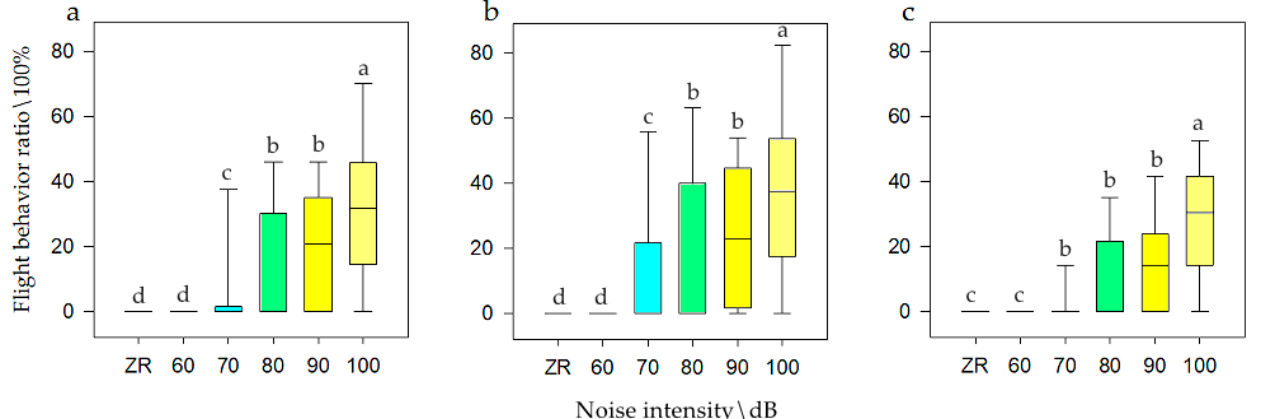
Figure 5. Flight behavior of bean geese (( a ) Population N; ( b ) Population N1; ( c ) Population N2) of different noise intensity (ZR (background noise), 60, 70, 80, 90, and 100 dB). Different letters in the graphs represent significant differences from one-way ANOVA and SNK tests. Bars represent means; error bars denote standard deviations. The bar with the highest flight behavior ratio is marked as “a”. The flight behavior ratio is compared with other noise gradient, and the difference is significant, marked as “b”, “c”, and “d”.